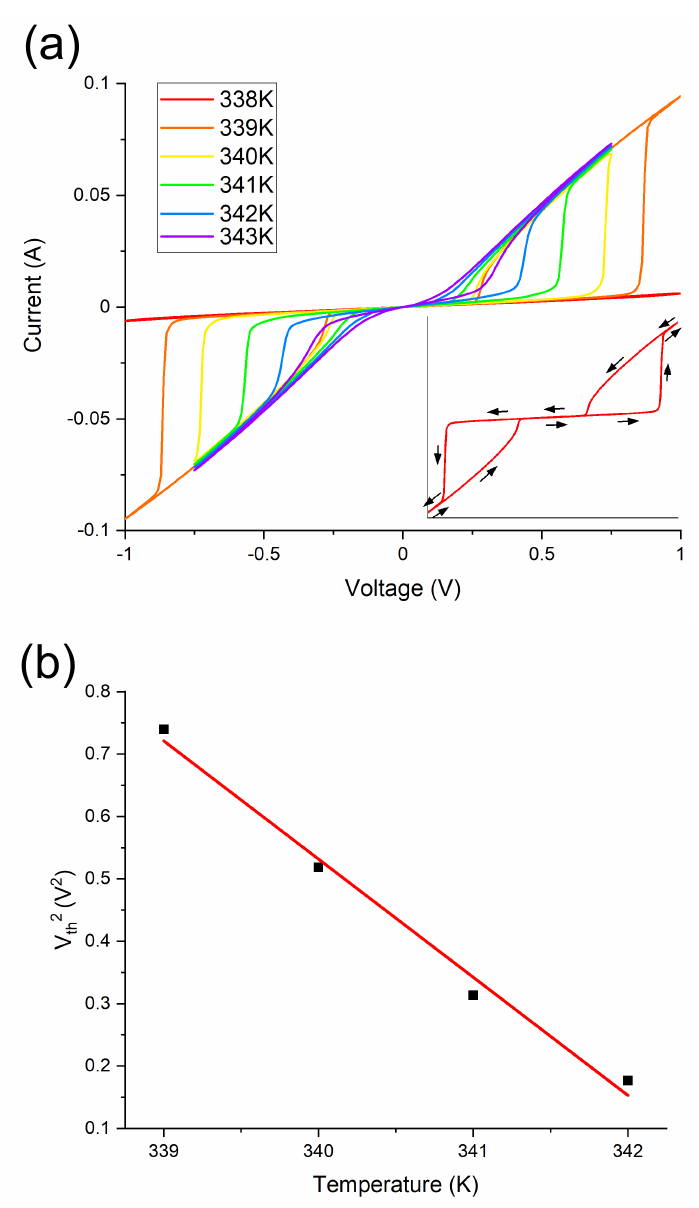
Figure 5. ( a ) Voltage–current measurements at a range of set temperatures. At the threshold voltage the current sharply increases corresponding to a drop in the resistance. This corresponds to the VO 2 switching to its metallic state. As the set temperature is reduced the threshold voltage increases. ( b ) plots the square of the threshold voltage against the set temperature. The linearity is evidence for a Joule heating-induced